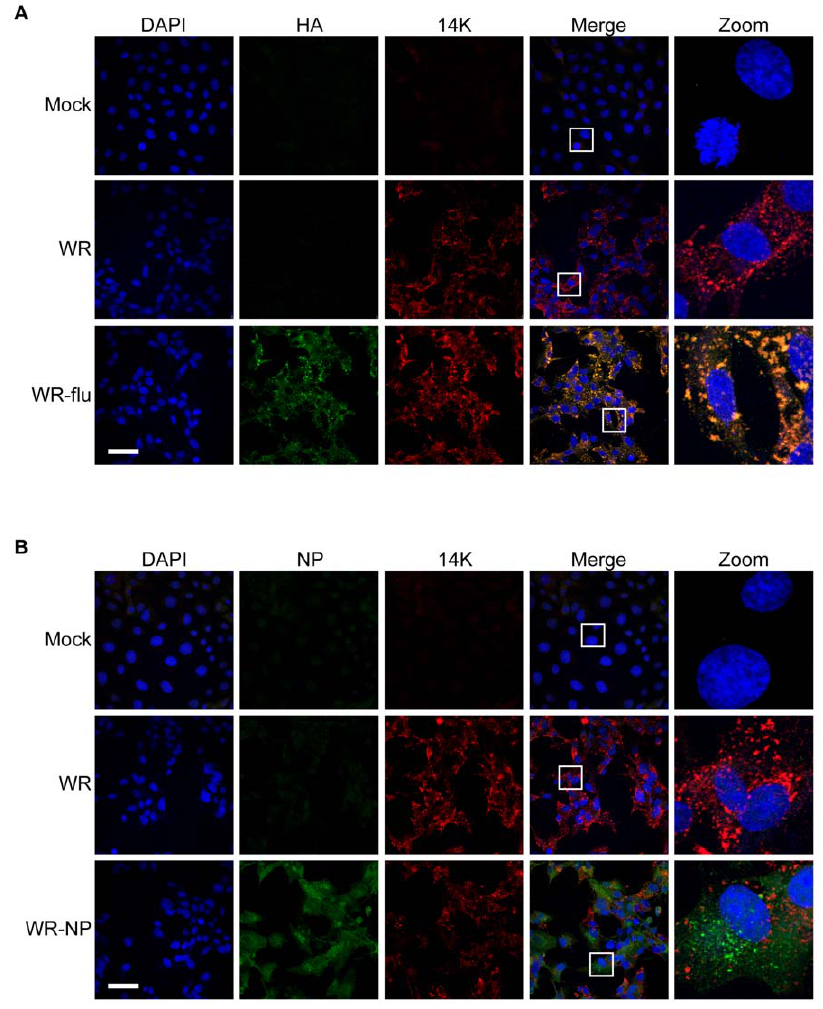
Figure 3. Recombinant influenza virus proteins are present in the cytosol of infected cells. BSC40 cells were infected with WR, WR-flu (A), or WR-NP (B) at an MOI of 1 PFU/cell. At 24 h p.i., cells were fixed with 2% paraformaldehyde, permeabilized, and stained with DAPI or antibodies recognizing influenza virus HA (A), NP (B), or vaccinia virus 14 K (A27 gene). Bar=25 m m.